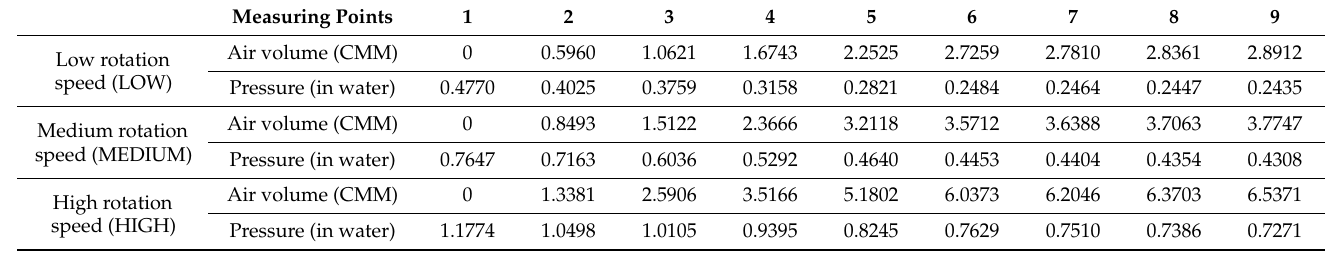
Figure 8. Wind tunnel experiment setup diagram of fan. Table 1. Pressure and air volume of the air purifier at different rotation speeds.